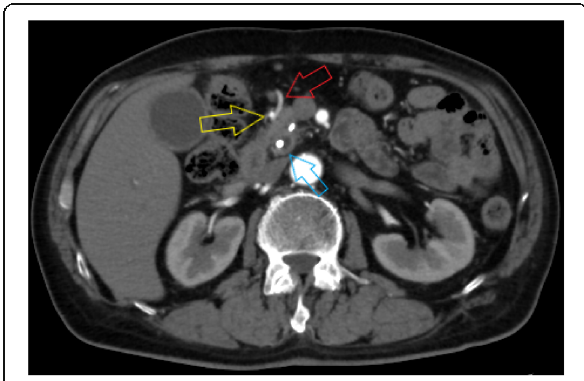
Fig. 4 The yellow arrow denotes GDA. The red arrow denotes RGEA. The blue arrow denotes the bile duct stenosis